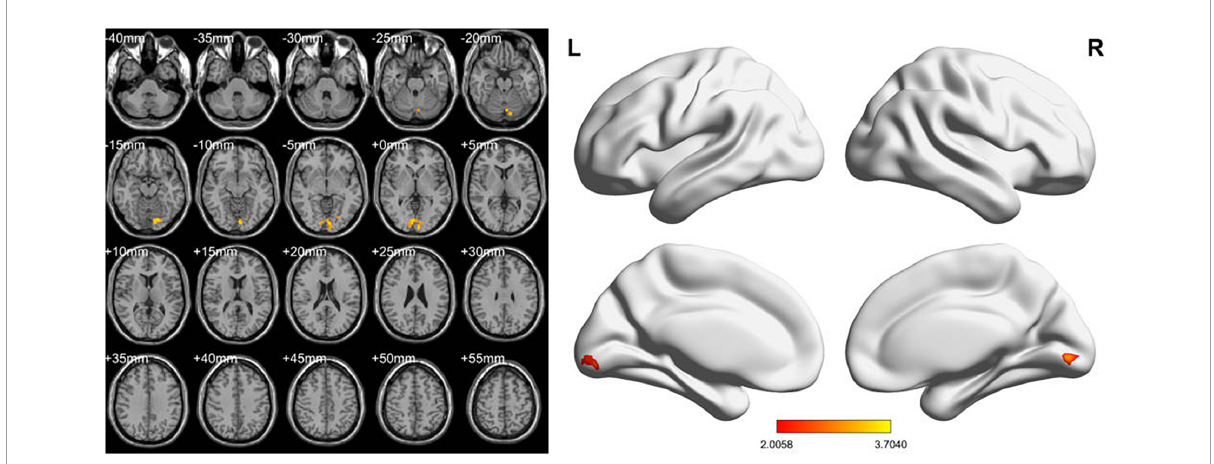
FIGURE3 fALFF values using two-sample t -tests in slow-4 band between LDH-pre patients and HCs. Increased fALFF values have been shown in the left Cerebelum_Crus1 in LDH-pre group compared with HCs (GRF correction, voxel p < 0.05 and cluster p < 0.05). Color bar indicates the t score (L, left; R, right).